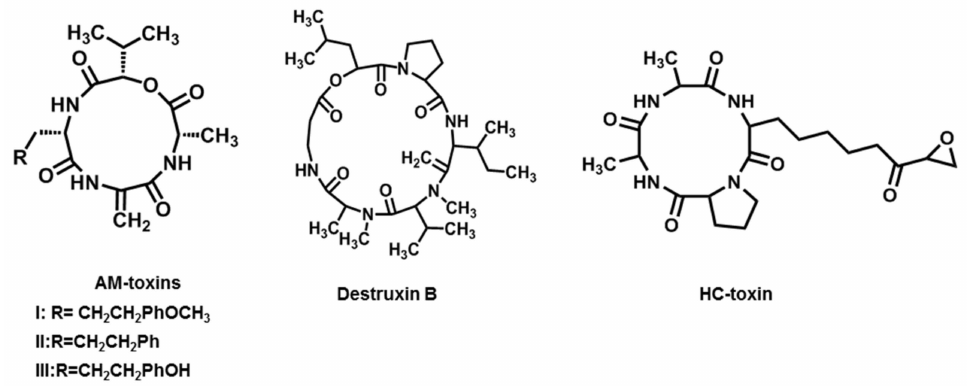
Figure 4. Chemical structures of AM-toxins, destruxin B, and HC-toxin. AM-toxins belong to the cyclic peptides that are generally synthesized via non- ribosomal pathways by non-ribosomal peptide synthetases (NPRS) [91]. The AMT1, AMT2, AMT3, and AMT4 genes have been successfully isolated encoding proteins resembling enzymes involved in the secondary metabolism and modification of amino acids [92,93]. In 2007, a bacterial artificial chromosome (BAC) was isolated containing four AMT genes and other genes that are upregulated in AM-toxin-producing cultures, suggesting that genes for AM-toxin biosynthesis are clustered in the genome. It also revealed that the AMT genes are located on a conditionally dispensable (CD) chromosome of <with a size of 1.8 Mb in the strain